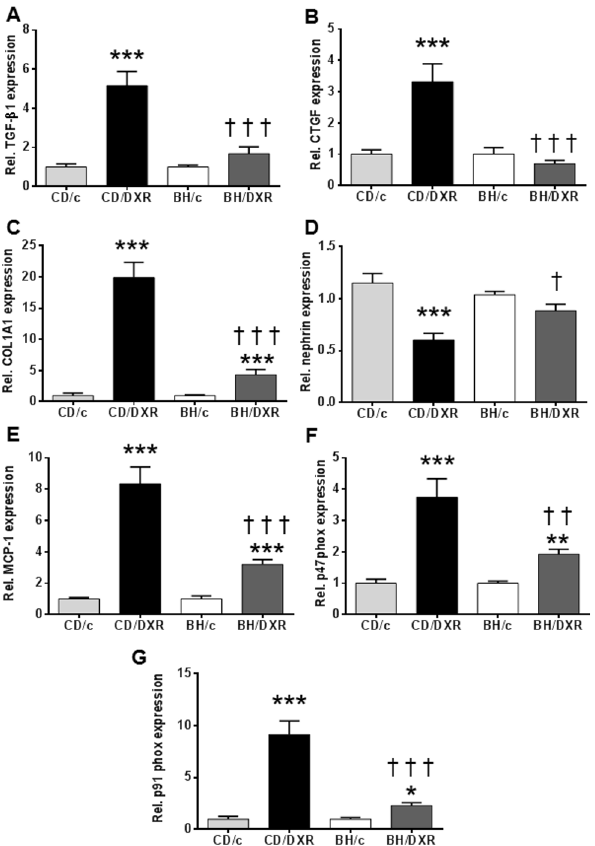
Fig 4. Renal cortical mRNA levels of fibrosis related, inflammatory and oxidative markers. ( A: TGF- β 1, B: CTGF, C: COL1A1, D: nephrin, E: MCP-1 F: p47 phox , G : p91 phox . CD: CD rats, BH: BH rats. c: saline- injected, DXR: Doxorubicin-injected rats (5 mg/kg). TGF- β 1: transforming growth factor β 1; CTGF: connective tissue growth factor; COL1A1: collagen type I alpha 1; MCP-1: monocyte chemotactic protein